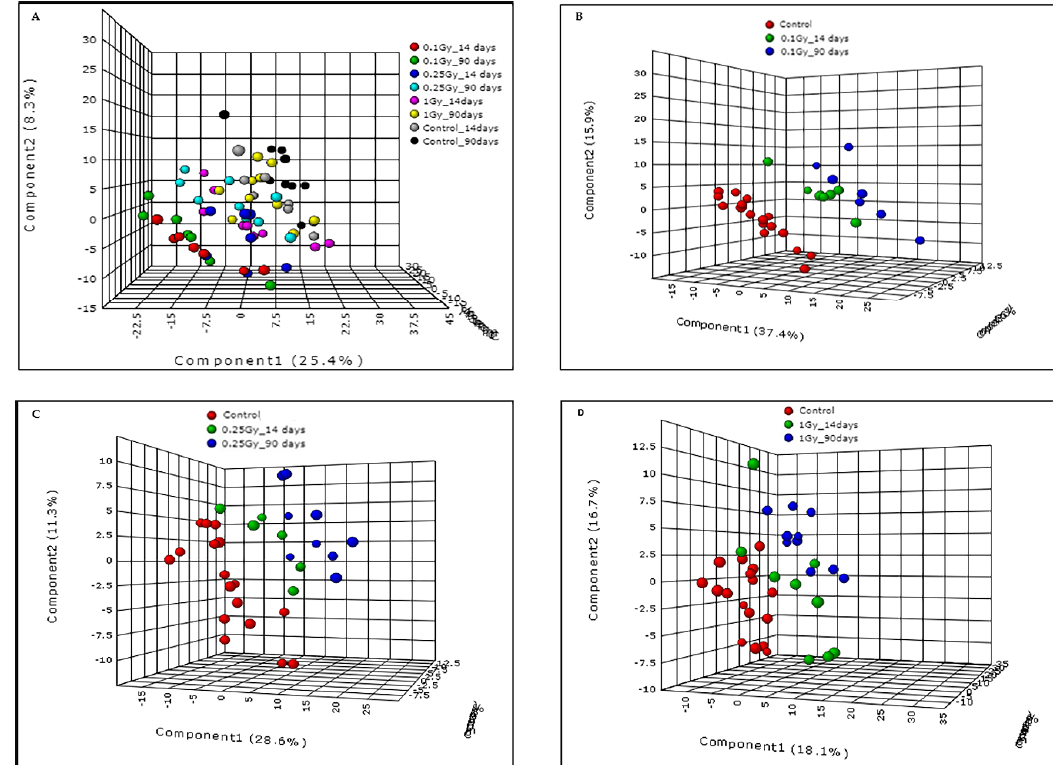
Figure 2. Exposure to low doses of 16 O radiation causes alterations in plasma molecular profiles. Panel ( A ): PLS-DA demonstrating separation between irradiated and sham groups across all doses and time points in this study. Panel ( B ): PLS-DA analyses showing clear separation between 0.1 Gy radiation group and sham at both 14 and 90 days post-irradiation. Panels ( C and D ): PLS-DA plots showing group separation for mice exposed to 0.25 Gy and 1 Gy as compared to sham.